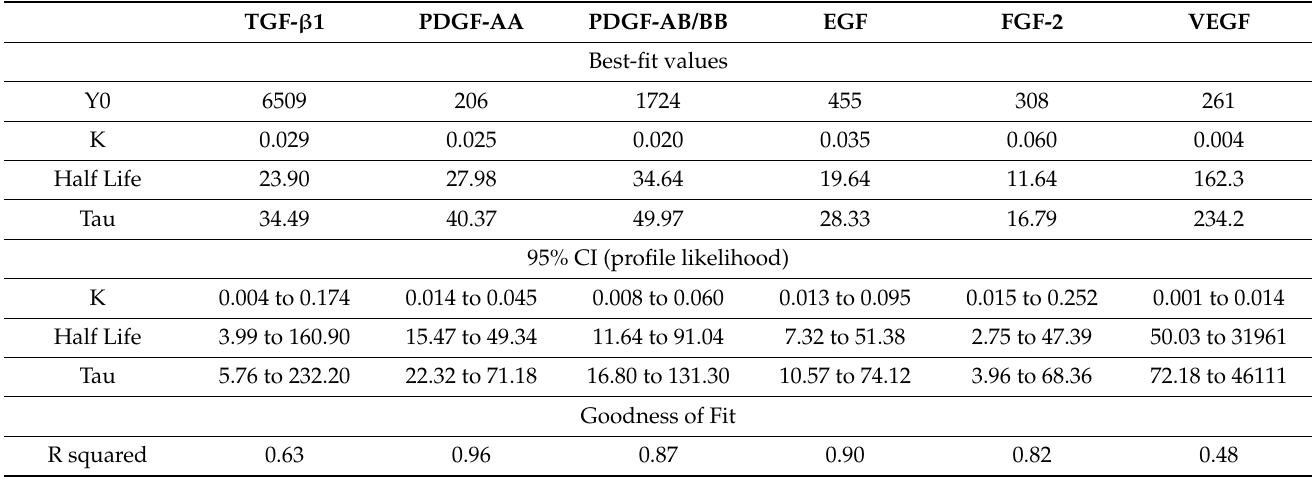
Table 5. Best-fit values, 95% CI and goodness of fit of the exponential decay of each growth factor ex